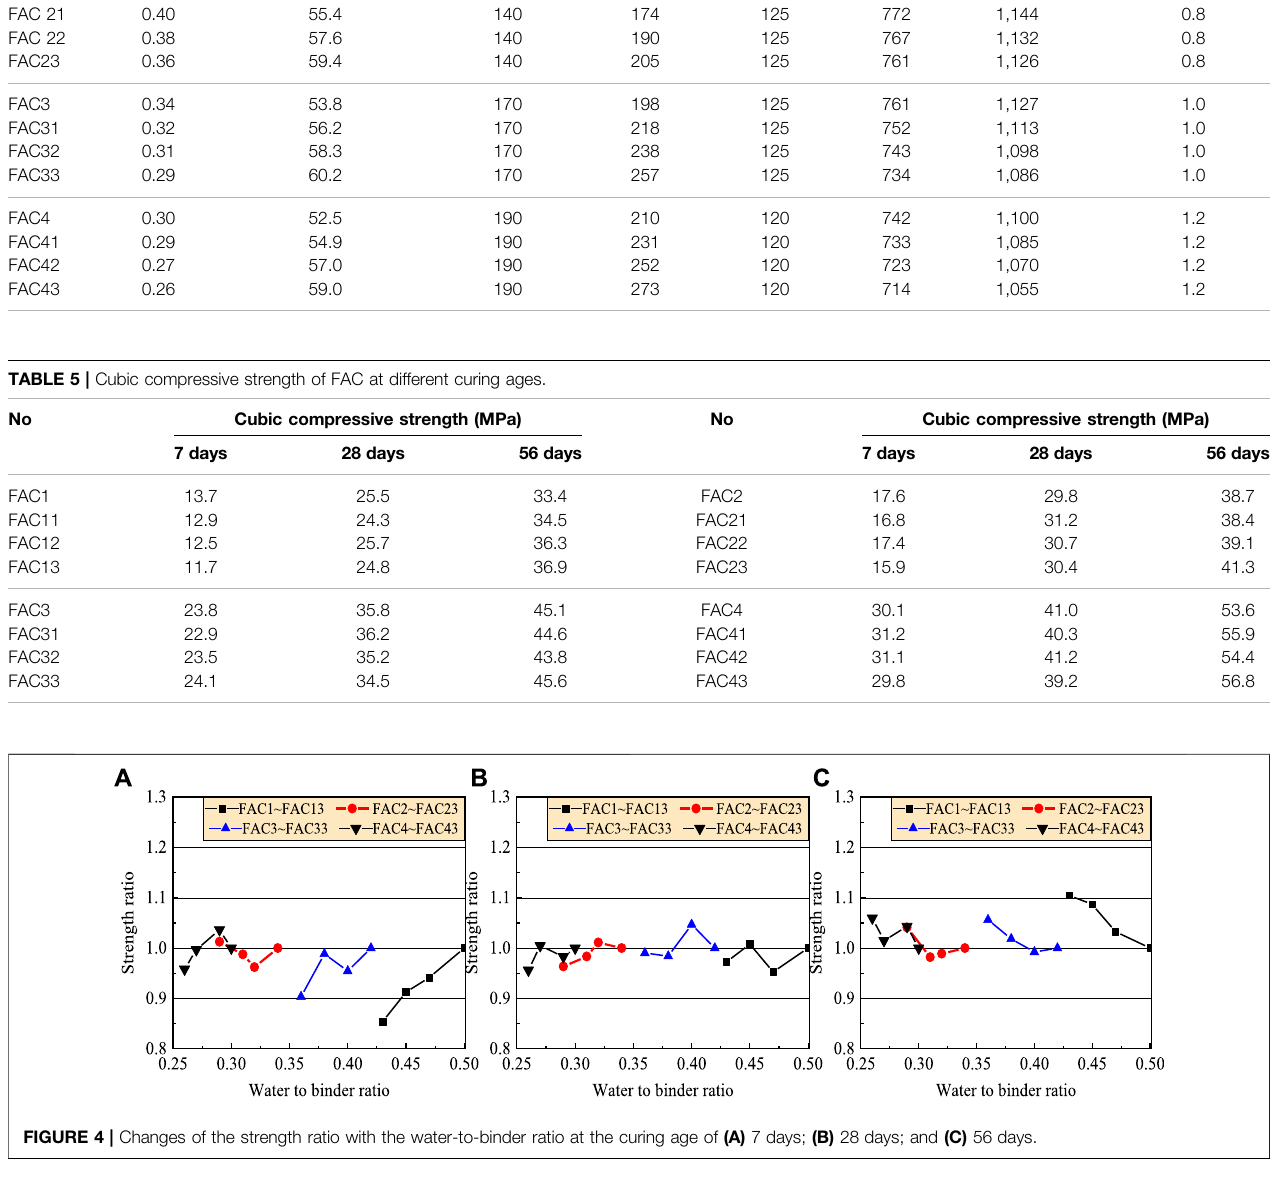
Frontiers in Materials |